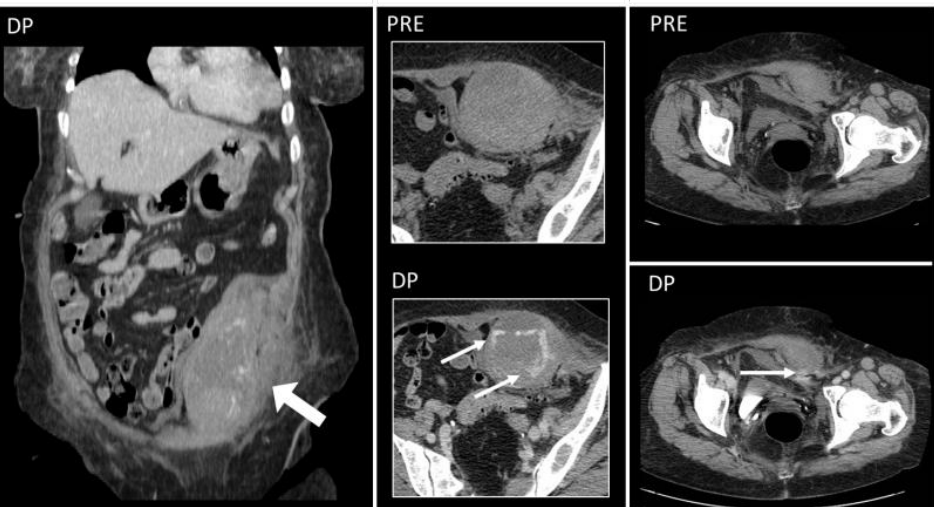
Figure 11. Hematoma below the arcuate line in a 75-year-old woman, with acute myeloid leukemia and low platelet count. After a cough, she started complaining of strong abdominal pain and a mass started growing. Coronal and axial, pre- and post-contrast injection images showed the presence of a large left rectus sheath hematoma (thick arrow) with active arterial bleeding, as demonstrated by the subsequent spreading of contrast in all phases acquired (thin arrows). Since the hematoma was below the arcuate line, bleeding into the prevesical space is also noted (arrow, last picture, bottom row).